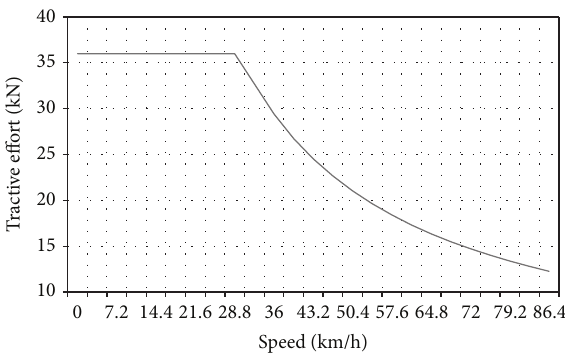
Figure2:Motionphases:MA:maximumacceleration,CR:cruising, CO: coasting, and BR: